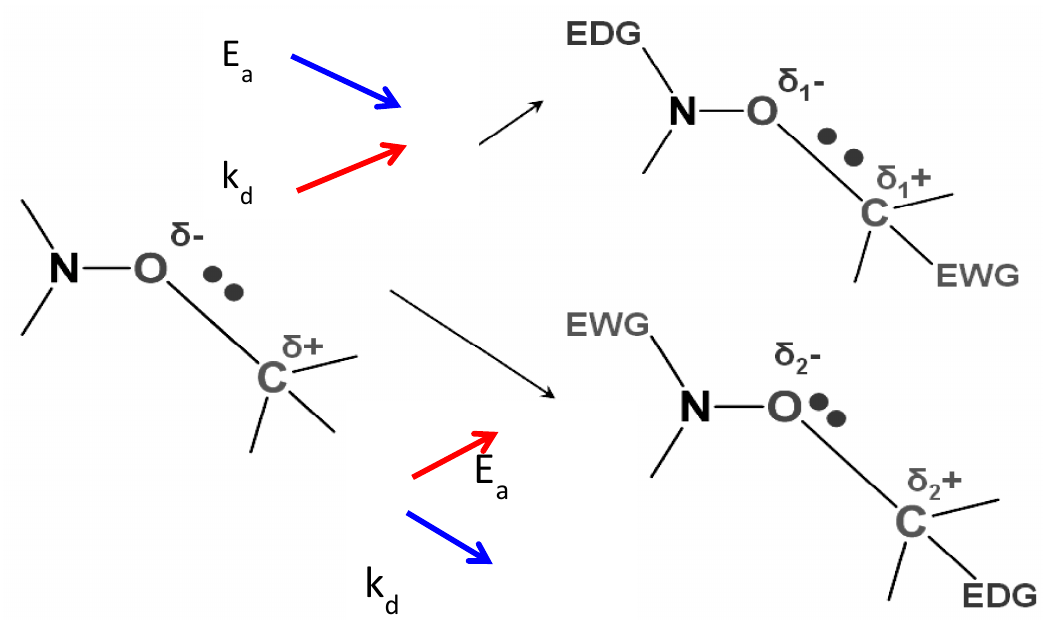
Figure 2. The influence of introduction of electron-withdrawing groups and electron-donating groups into the alkyl and nitroxyl part of an alkoxyamine on the polarity of the C–ON bond and thus the rate of homolysis.